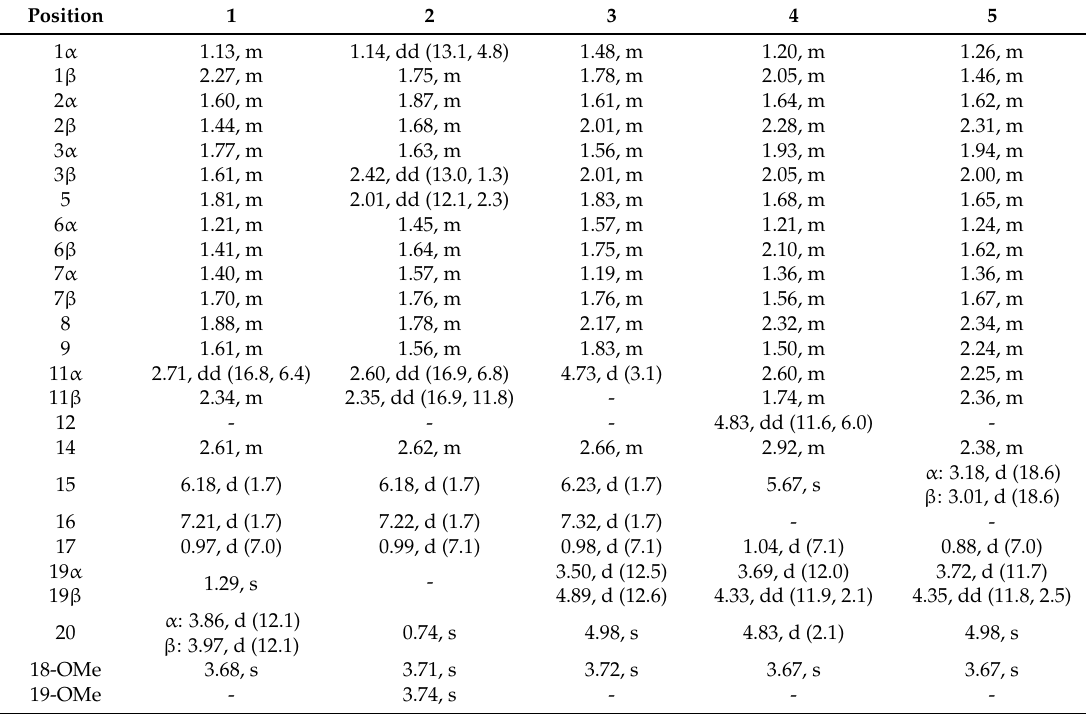
Table 1. 1 H-NMR spectroscopic data (600 MHz, CDCl 3 ) for compounds 1 - 5 ( δ H in ppm, J in Hz). Position